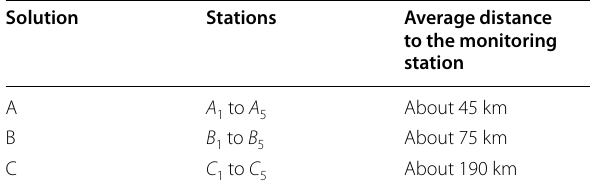
Table 2 Three PPP-RTK service solutions